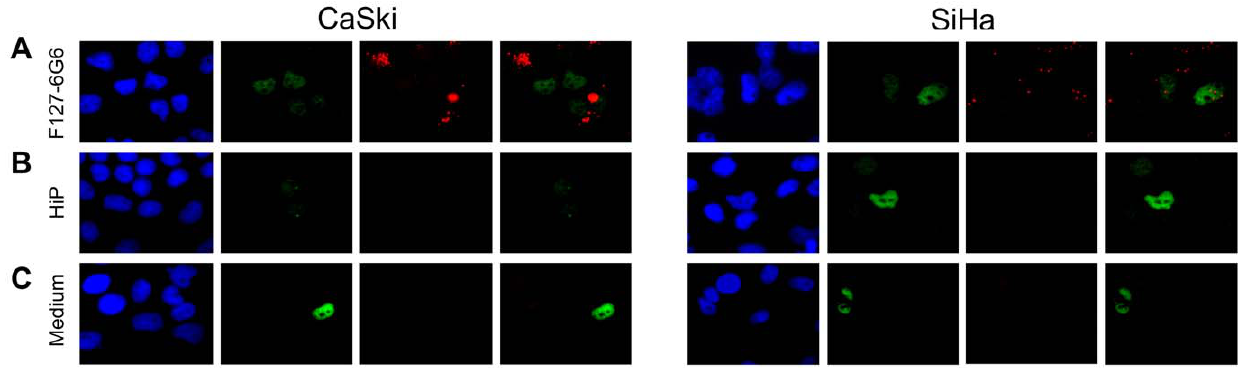
Figure 7. Immunofluorescence demonstrating p53 expression (green) and detection of F127-6G6 E6 antibody (red) following chemical transfection. (A) Transfection with 40 m g/mL F127-6G6 antibody. (B) Cells treated with only the HiPerFect (HiP) transfection reagent. (C) Cells receiving culture medium alone. Nuclei were counterstained blue with DAPI. p53 and F127-6G6 images merged (right most photo). Cells were visualized using 400 6 magnification 48 hours following transfection. The images were cropped and zoomed in to better demonstrate the colocalization of p53 and E6 antibody staining.